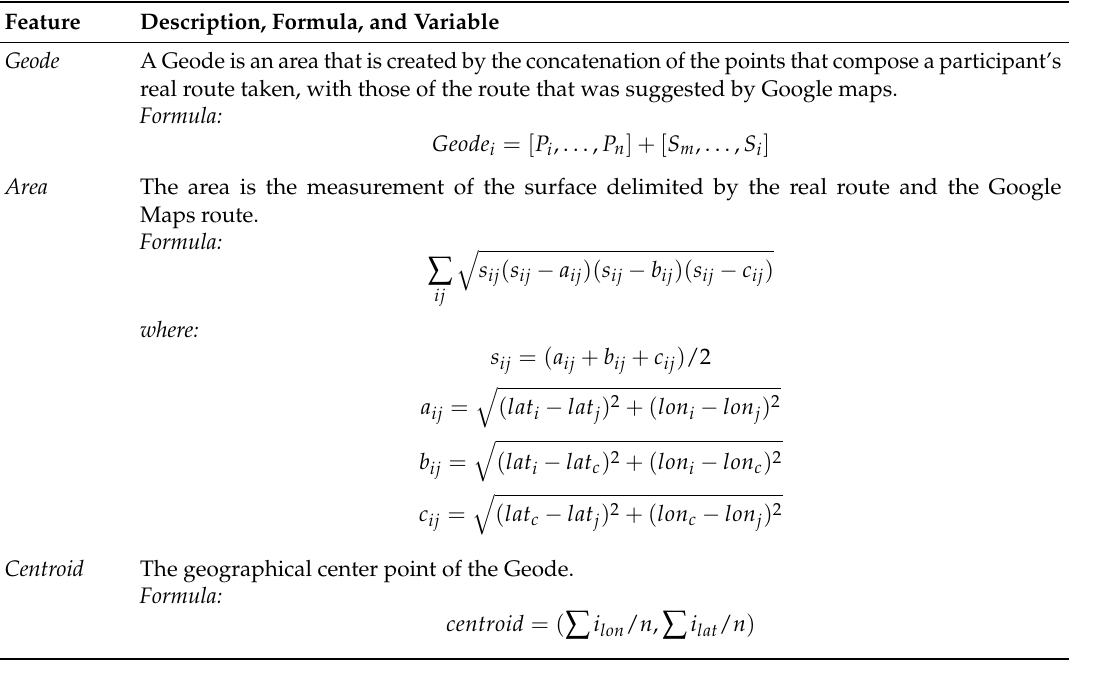
Figure 4. A Geode is an area that is formed between a route suggested by Google Maps and the Actual route the participant took. The area is formed, since both routes share a starting and an ending point. Table 3. Features associated with